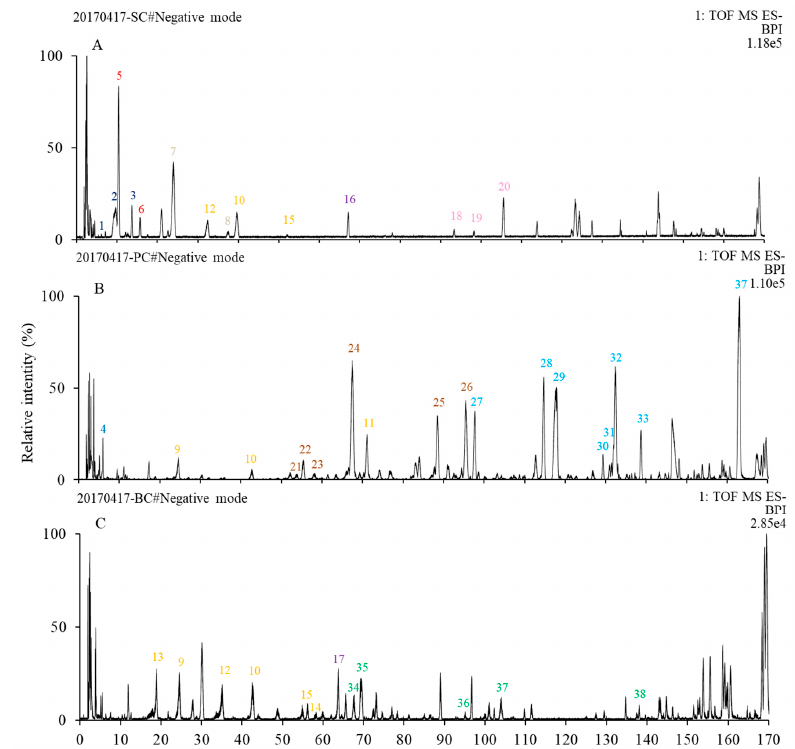
Figure 5. UPLC-QTOF-MS spectra of SC ( A ), PC ( B ) and BC ( C ). Numbers in ( A – C ) correspond to those peak numbers in Table 1. SC, PC, and BC were abbreviations of S. cuneata , P. cuspidatum , and B championii , respectively.